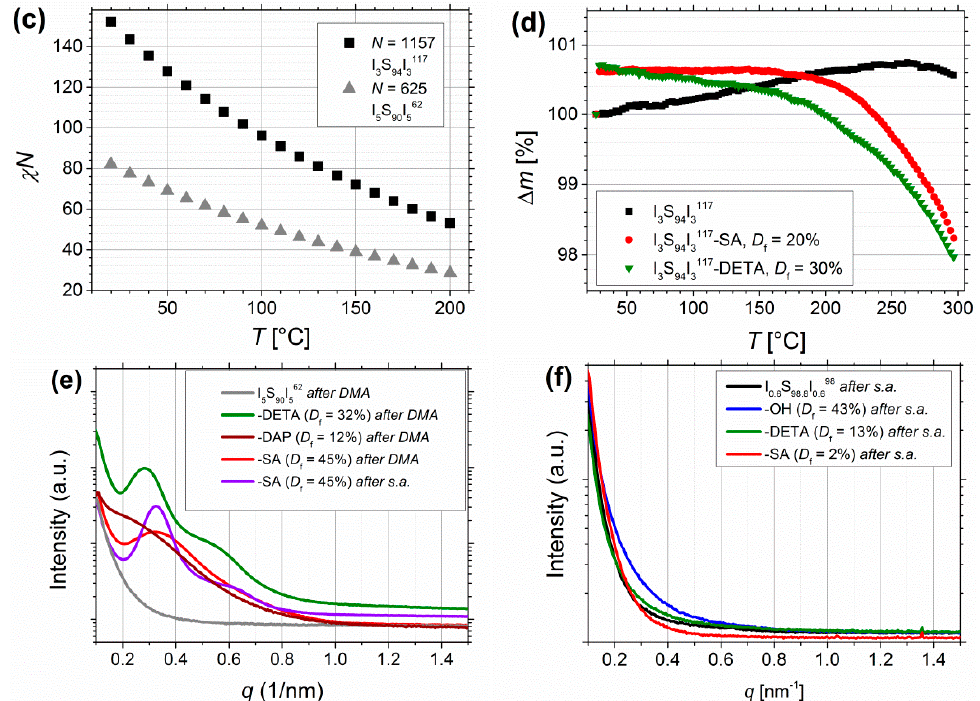
Figure 11. ( a ) DSC curves of pure I 5 S 90 I 562 (black), after functionalization with OH ‐ (blue), DETA ‐ (green), DAP ‐ (brown) and SA ‐ groups (red). Data were recorded on Mettler ‐ Toledo DSC 1, and additionally processed for smoothening. ( b ) DSC curves of I 0.6 S 98.8 I 0.698 before and after functionalization with OH ‐ (blue), DETA ‐ (green), and SA ‐ groups (red). Data were recorded on NETZSCH DSC 204 F1 Phoenix with no additionally data processing. ( c ) temperature ‐ dependent, calculated values of χ N for I 5 S 90 I 562 and I 3 S 94 I 3117 . ( d ) TGA of unfunctionalized I 3 S 94 I 3117 (black, 5 mg), followed by carboxylated ( D f = 30%, red, 7.2 mg), and DETA ‐ functionalized ISI ( D f = 20%, green, 4.6 mg). SAXS curves of I 5 S 90 I 562 ( e ) and I 0.6 S 98.2 I 0.698 ( e ) films before and after modification ( after DMA : after angular frequency dependent oscillatory measurement at 120–180 °C, after s.a. : after solvent annealing).